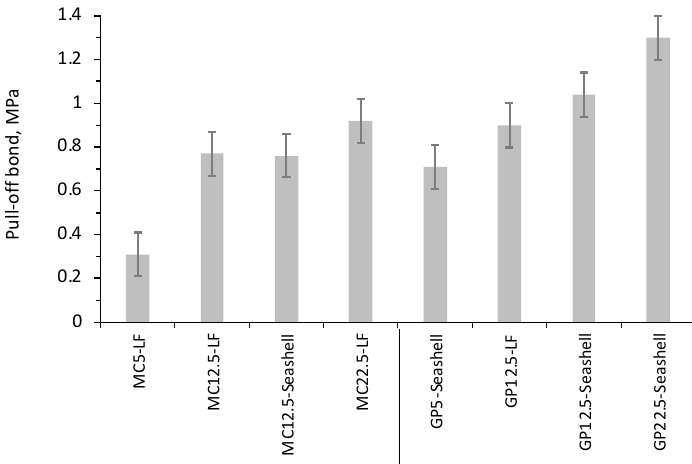
Figure 5. Pull-off bond strengths for MC and GP mortars.